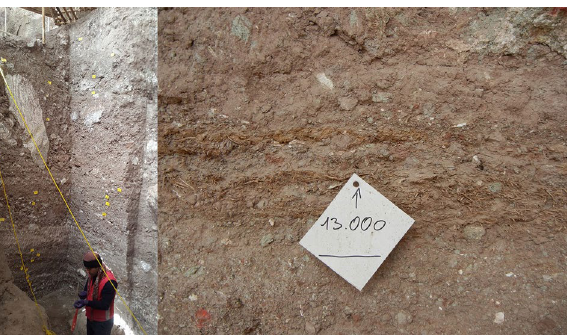
Figure 1. Sampling location: samples were retrieved from vertical layers in 10 to 15 m depth. Edited by Microsoft paint, version 21 H2, https:// www. micro soft. com/ en- us/ windo